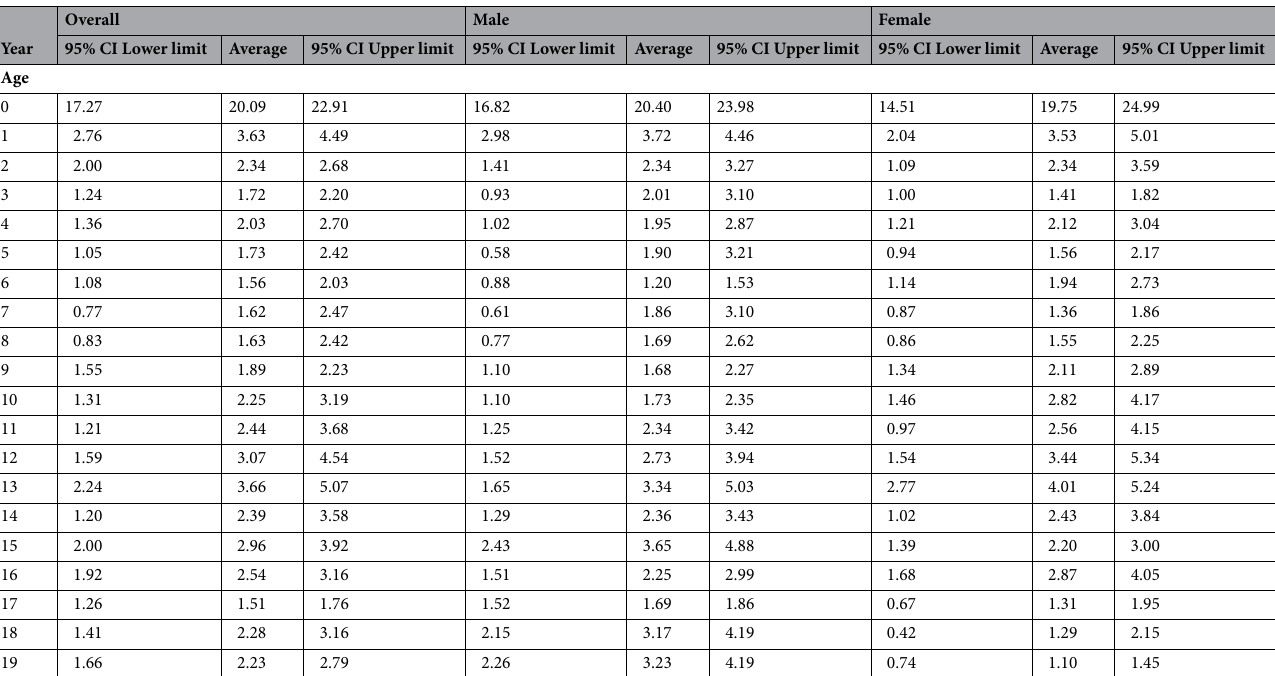
Table 3. Sex-specific and age-specific average incidence rate of congenital scoliosis for 5 years (2011–2015). *Annual incidences are represented in terms of the number per 100,000 persons. *Korean Statistical Information Service (KOSIS; http://kosis .kr) data was used to determine the total population according to age during the study period, allowing the calculation of sex-specific and age-matched annual incidences. *95% CI indicates 95% confidence